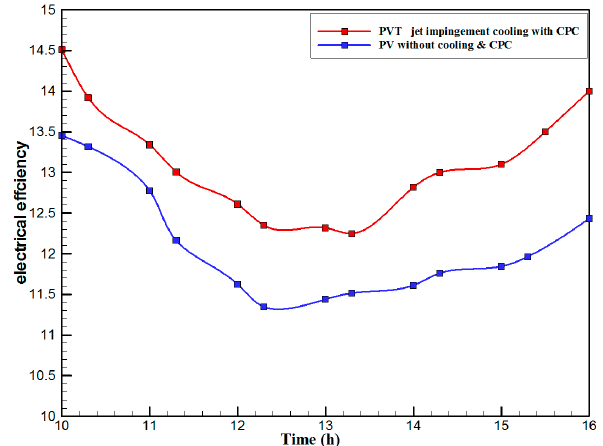
Figure 9. The hourly variation of electrical efficiency for the PVT solar collector with CPC and electrical efficiency for the PV module without cooling and CPC.